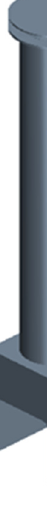
Figure 2. Air circulation system model.